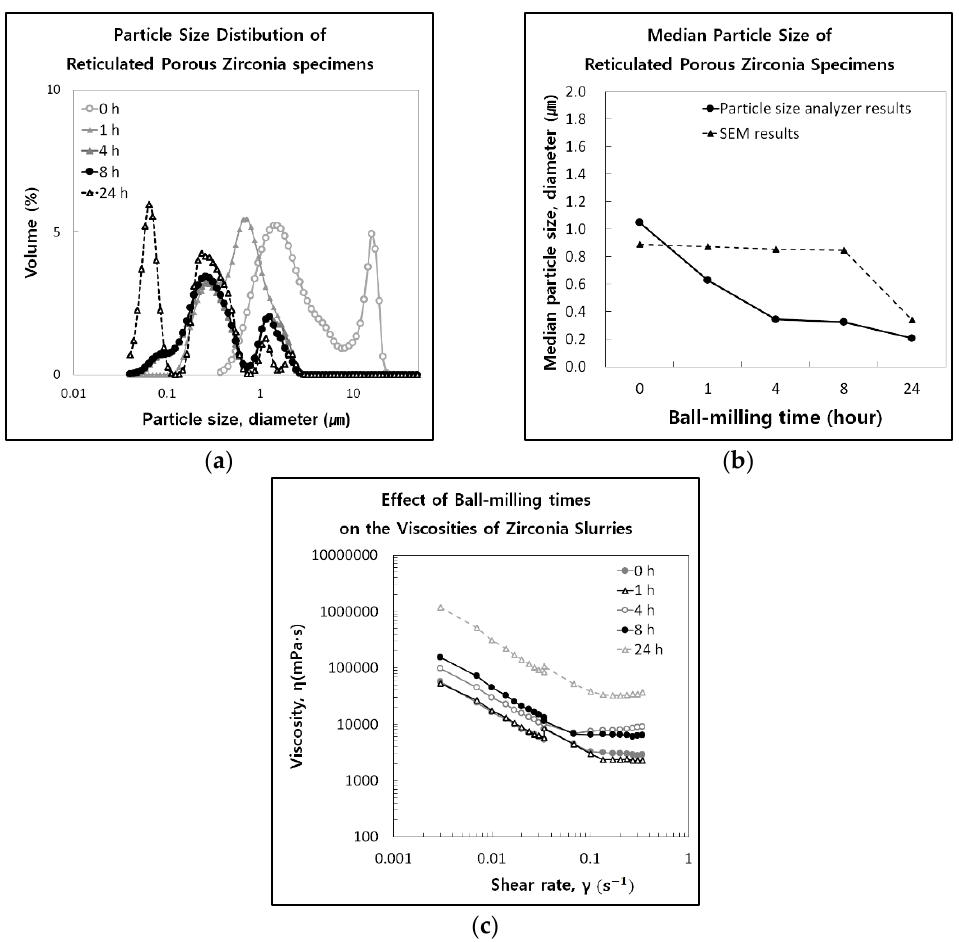
Figure 4. ( a ) Particle size distribution, ( b ) median particle size distributions and ( c ) viscosities of zirconia slurry samples ball-milled for 0, 1, 4, 8, and 24 h.